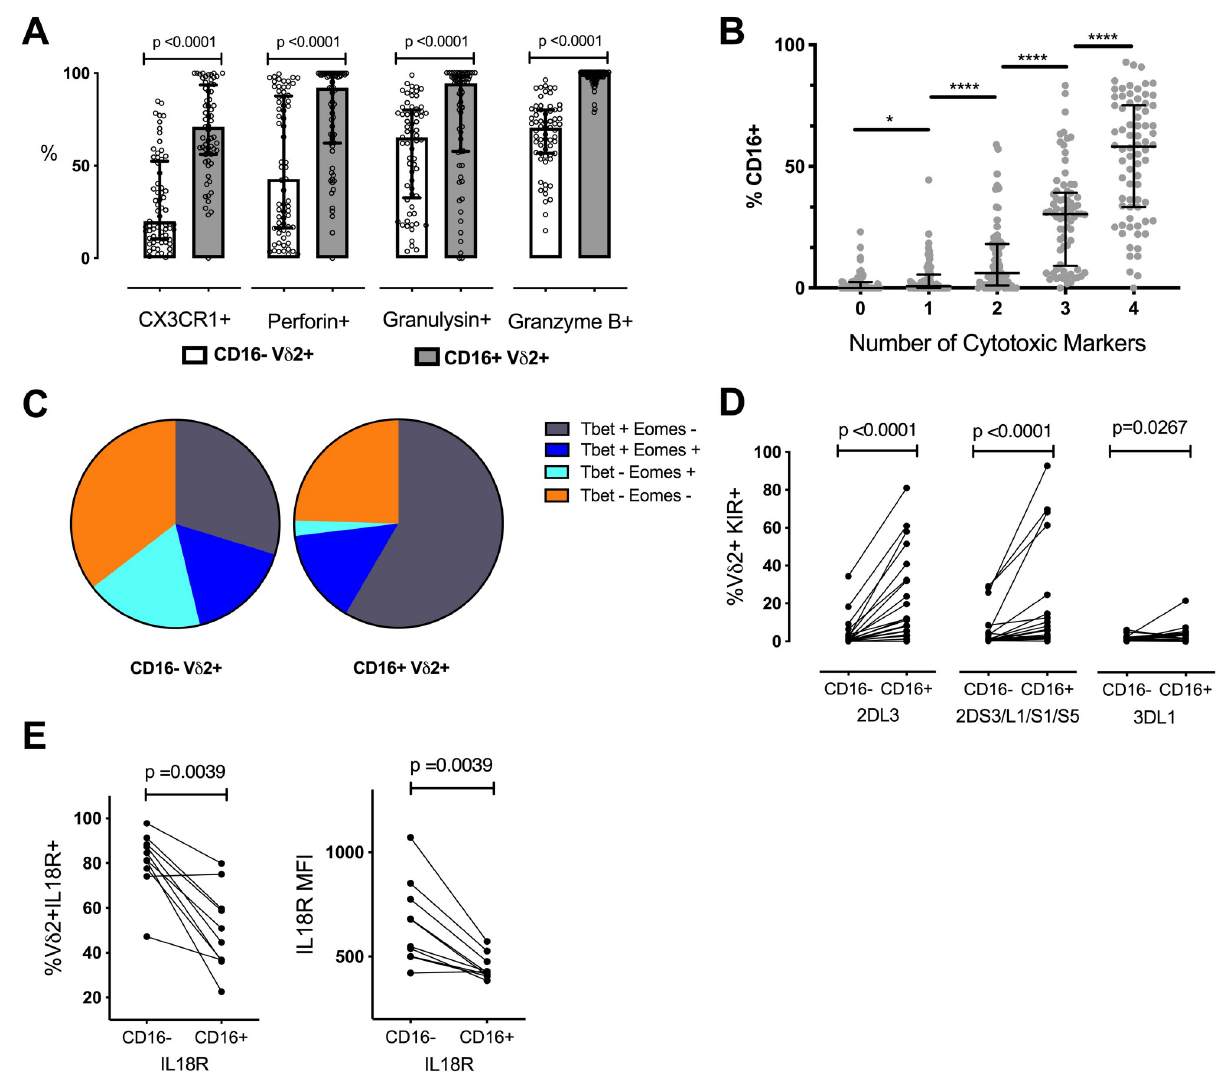
Fig 1. CD16+ V δ 2 T cells are more likely to express cytotoxic markers and KIRs. (A) The percentage of CD16+ and CD16-V δ 2 T cells expressing relevant cytotoxic markers are shown (n = 65; scatter plot with median and IQR). (B) V δ 2 T cells positive for 4 or any combination of 3, 2 or 1 of the cytotoxicity markers listed in A are grouped along the x-axis and their relative percentage of CD16 is shown (n = 65; scatter plot with median and IQR). (C) The percentage of CD16+ and CD16-V δ 2s expressing the listed combinations of the transcription factors Tbet and Eomes are shown. (n = 65). (D) The percentage of CD16+ and CD16-V δ 2 T cells expressing the listed KIR or KIR combinations is shown. Individuals who were genotype negative for the listed KIRs were omitted from this analysis (n = 22 for KIR3DL1 and KIR2DS3/L1/S1/S5; n = 20 for KIR2DL3). (E) The percentage of CD16+ and CD16-V δ 2 T cells expressing IL18R α and the MFI of IL18R α on CD16+ and CD16-V δ 2 T cells is shown (n = 10). All V δ 2+ T cells shown were gated on singlets and CD3+ events to exclude NK cells. P values for A, B, D and E determined by Wilcoxon matched pairs signed rank